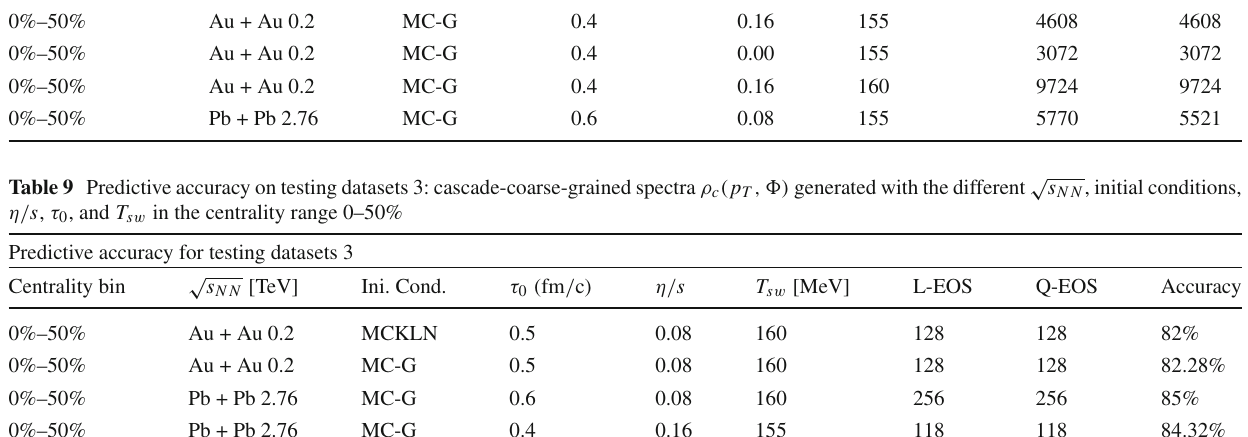
√ s NN ,initialconditions,